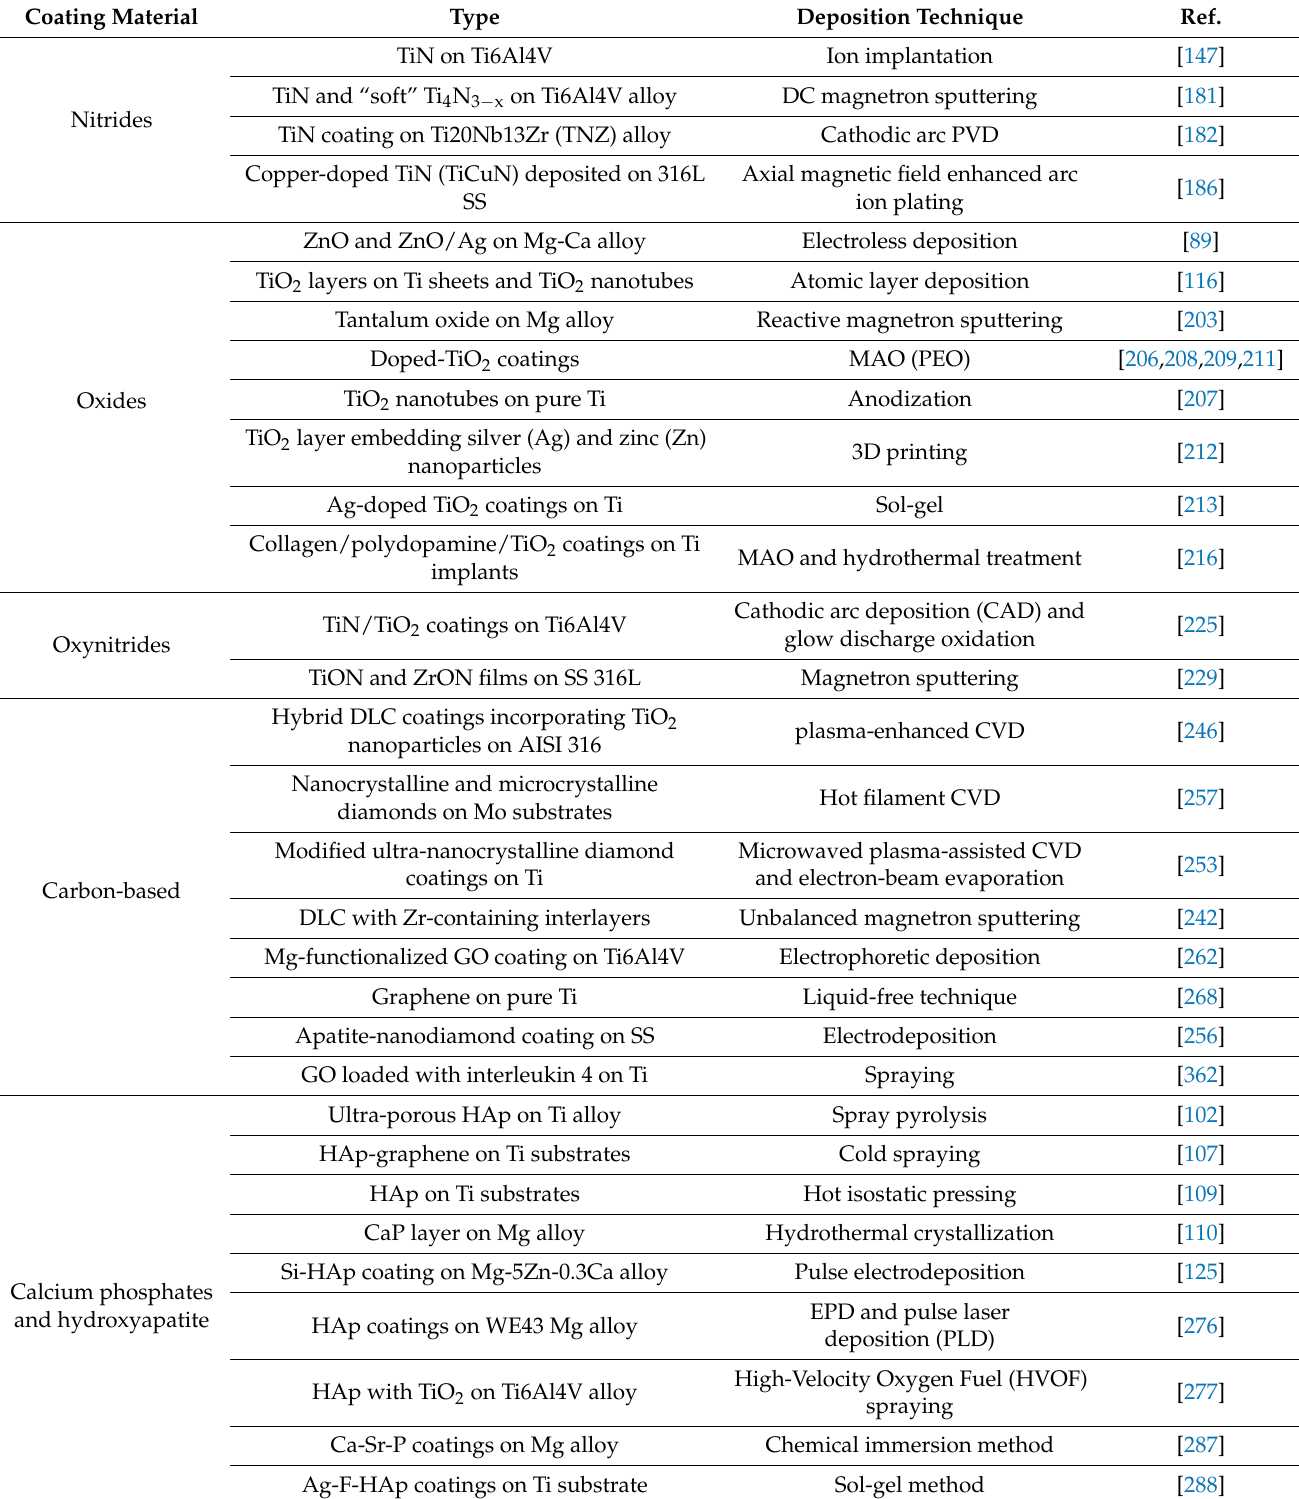
Table 4. Typical production techniques used for the deposition of various bioactive coating materials on metallic